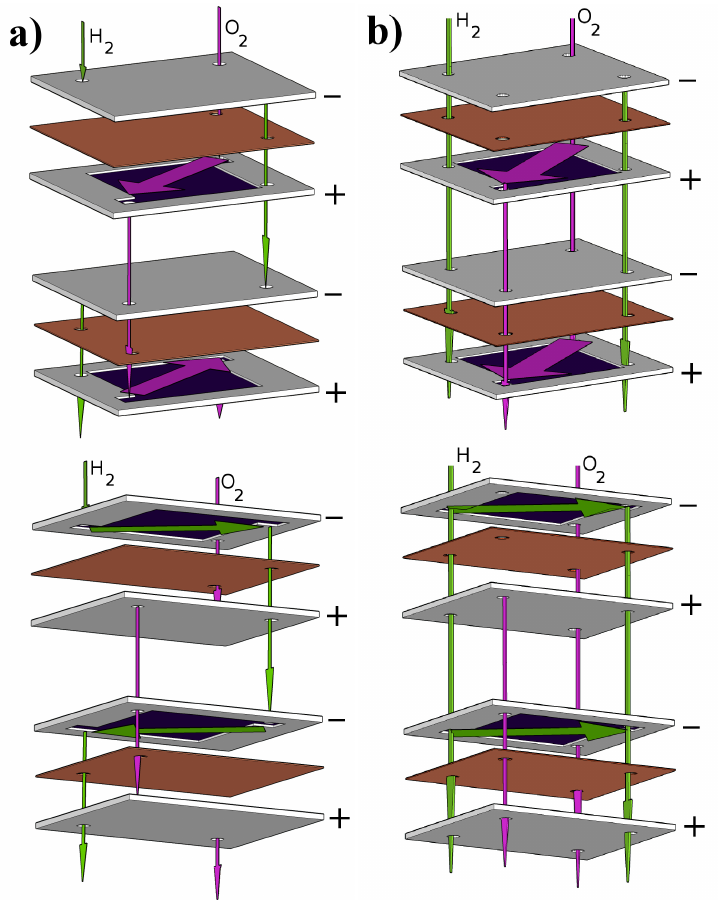
Figure 4. Illustration of gas flows in the two stacking solutions described in this work. ( a ) Serial gas flow in a two-cell stack. ( b ) Parallel gas flow in a two-cell stack. Both images have two views, to facilitate the following of the